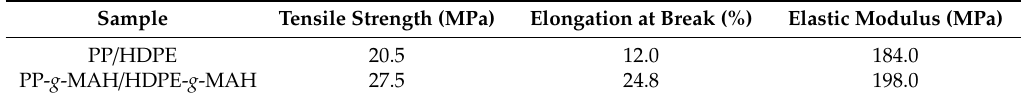
Figure 7. Stress and strain curves of PP / HDPE and PP- g -MAH / HDPE- g -MAH. Table 5. Mechanical properties of PP / HDPE and grafts.